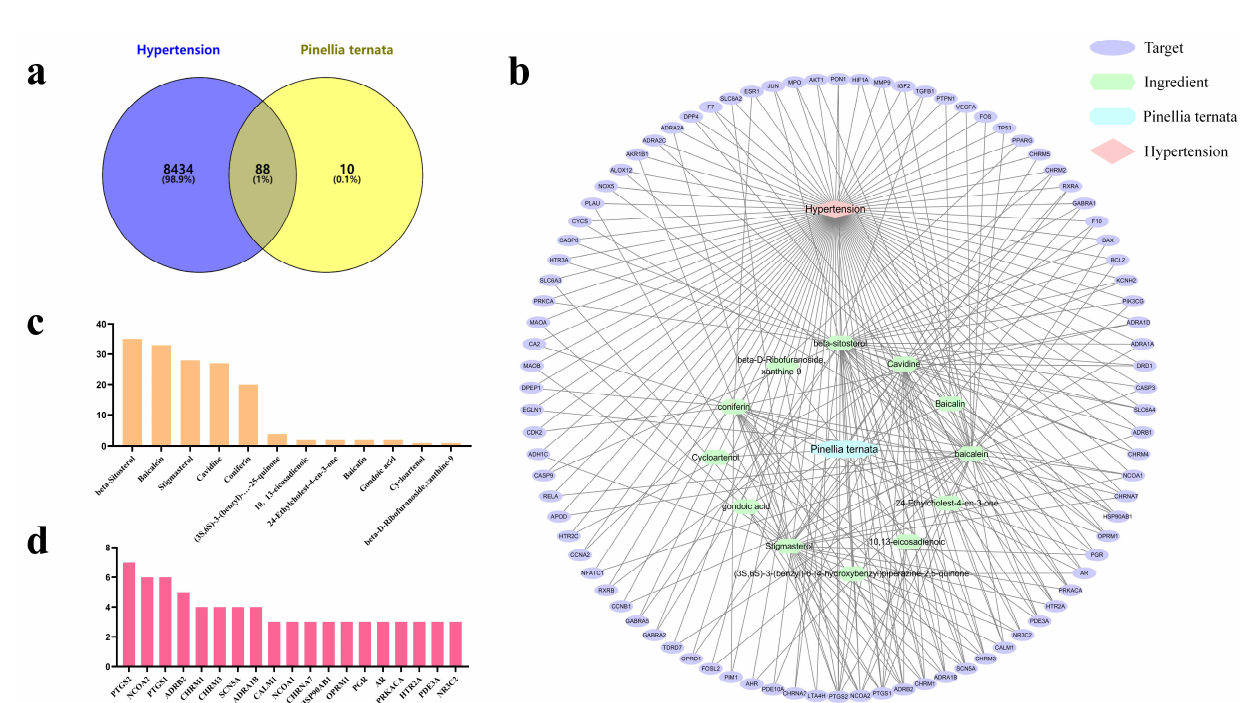
Figure 1. Compound-Target network. ( a ) Venn diagram shows that 8522 targets of hypertension are screened, 98 targets of P. ternata are screened, and the intersection indicates that there are 88 targets of P. ternata for hypertension. ( b ) Compound- target network, purple ellipse represents the target of P. ternata , green hexagon represents the active ingredient of P. ternata , blue polygon represents P. ternata , and red quadrilateral represents hypertension. ( c ) Statistics of degrees of effective components, X -axis represents effective components, Y -axis represents degrees. ( d ) Statistics of the degree of the target, the X -axis represents the target, and the Y -axis represents the